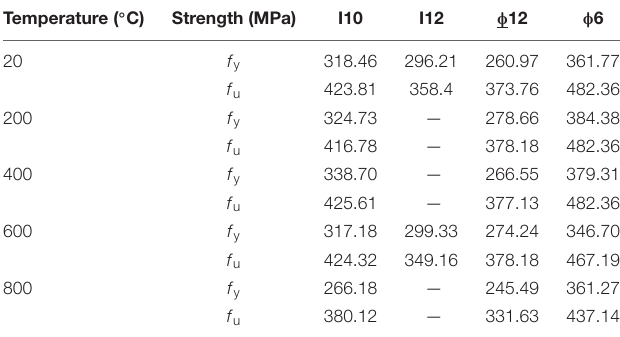
TABLE 3 | Steel mechanical properties at different